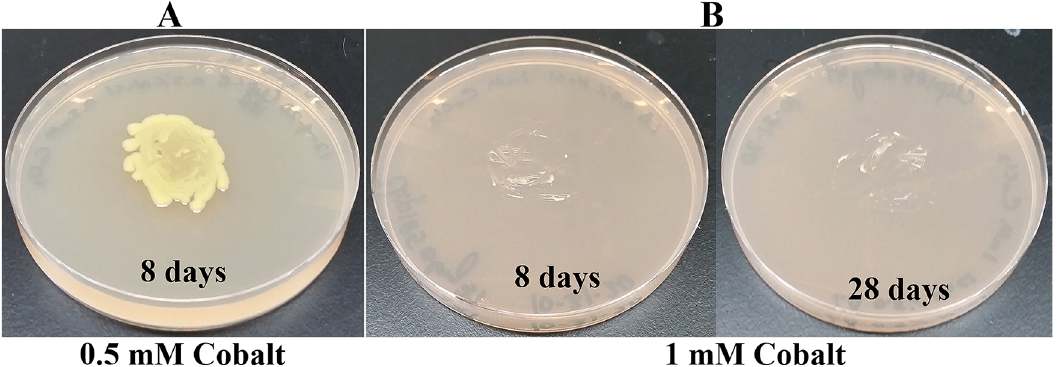
Figure 15. Growth of Clip185 on LBmedia containing Cobalt. (A) 8 days-growth of Clip185 on LB media containing 0.5mMCobalt.(B)8days(left)and28days(right)-growth ofClip185onLBmediacontaining1mMCobalt.Numberof days of growth are labeled on the figures. Light intensity was 10-15 μ mol m -2 s -1 .